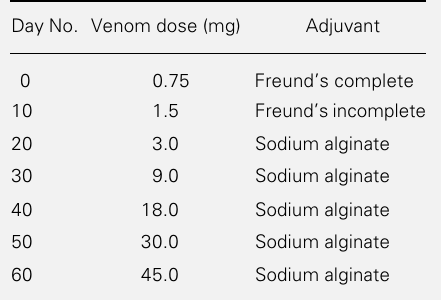
Table 1 - Immunization schedule for the produc- tion of B. atrox monovalent and crotaline polyva- lent antivenoms at Instituto Clodomiro